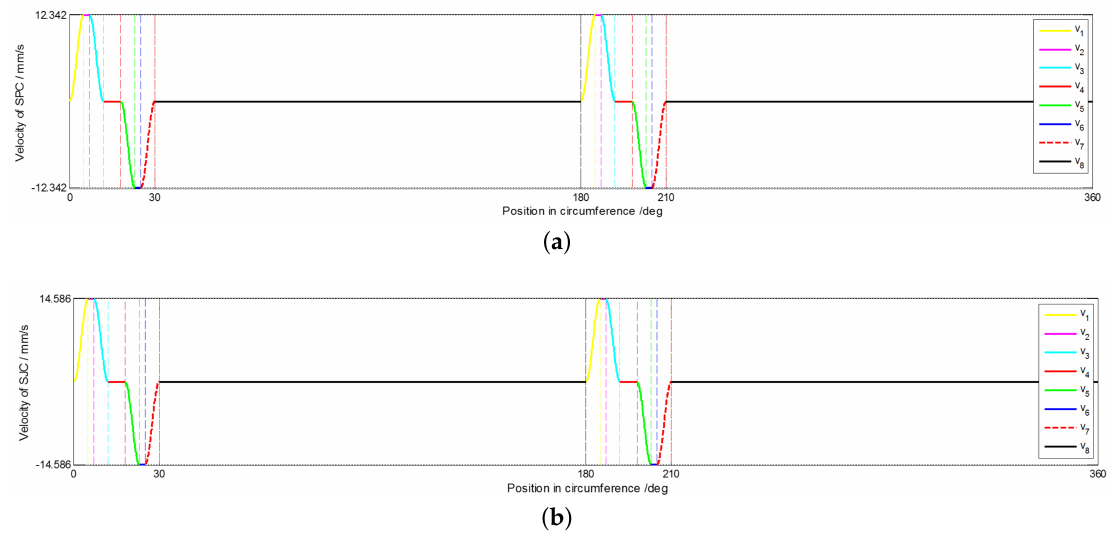
Figure 7. The velocity curves of SPC and SJF. ( a ) The velocity of SPF pushed by SPC. ( b ) The velocity of SJC pushed by SJF.